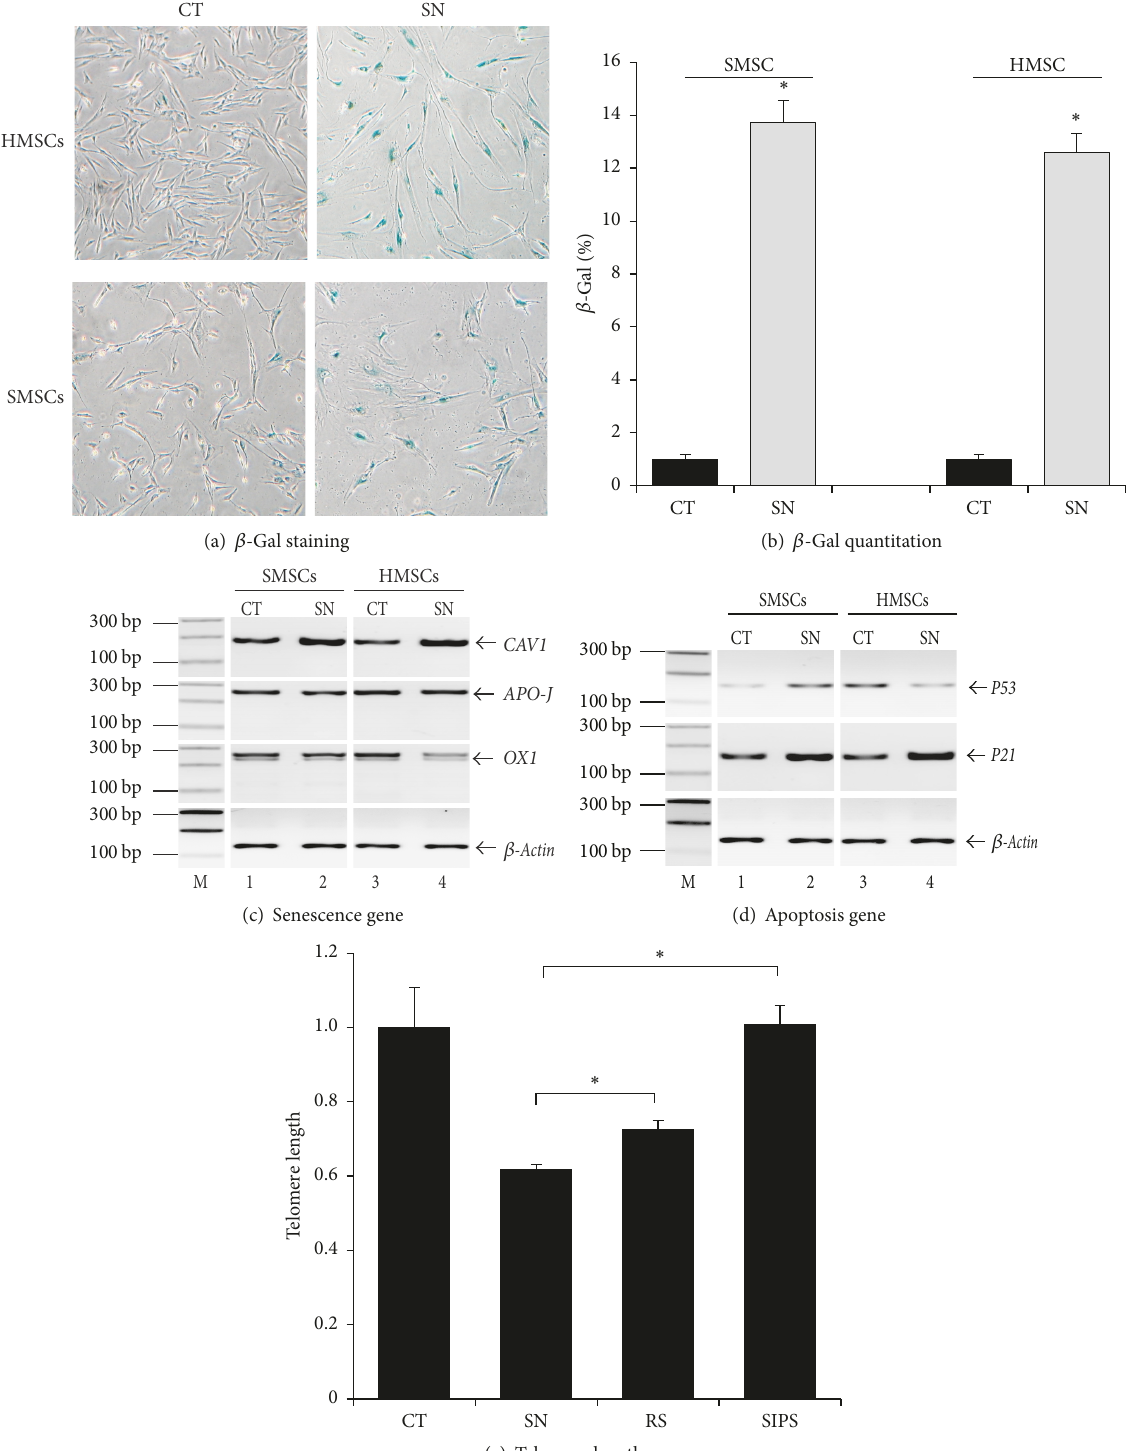
Figure 2: Induction of premature senescence in MSCs. (a) Induced senescence in MSCs. Senescence was induced by continuous exposure of HMSCs (heart-derived MSCs) and SMSCs (skin-derived MSCs) to a low dose of H 2 O 2 (50 𝜇 M) and low serum (5% FBS) in the culturing medium. CT: control HMSCs treated with PBS; SN: senescent HMSCs treated with 50 𝜇 M H 2 O 2 for 14d ( × 10). (b) Quantitation of 𝛽 -Gal cells. Cells were counted under microscopy. The results are expressed as the mean ± standard deviation of 𝛽 -Gal positive cells per field. ∗ 𝑃 < 0.05 as compared with the PBS control. (c) Senescent-related genes. Senescent HMSCs were harvested and RNA were extracted. RT-PCR was carried out to amplify senescence-related genes, including caveolin-1, apolipoprotein J, and OX 1. (d) Apoptosis-related genes. Expression of p53 and p21 genes was measured by RT-PCR. (e) Telomere length in senescent HMSCs. The relative length of telomere was estimated by qPCR as the ratio between the copies of telomere and the copies of 𝛽 -globin (T/S). ∗ 𝑃 < 0.05 as compared with the replicative senescence and high H 2 O 2